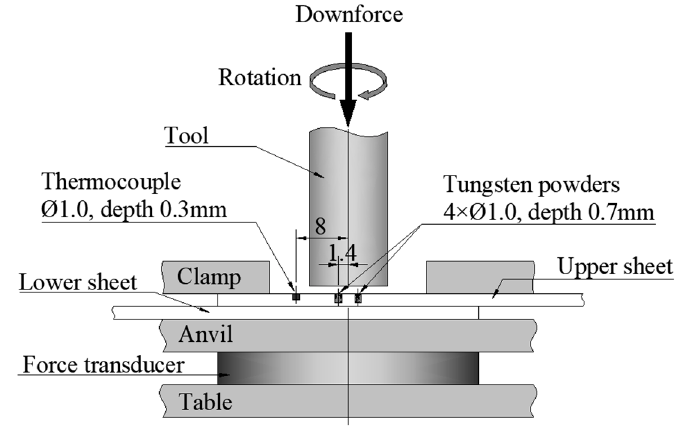
Figure 2. Schematic of the P-FSSW process and position illustration of the blind holes.